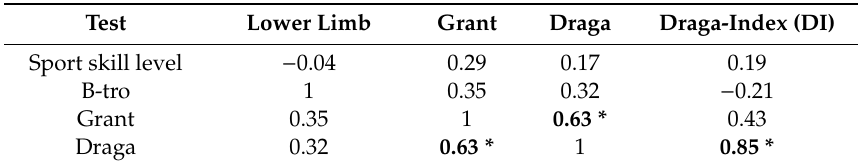
Table 4. Pearson’s linear correlations of motor variables and lower limb length with sport skill level on the Watts RP scale in the group of 7b–9a RP climbers. Test Lower Limb Grant Draga Draga-Index (DI) Sport skill level − 0.04 0.29 0.17 0.19 B-tro 1 0.35 0.32 − 0.21 Grant 0.35 1 0.63 * 0.43 Draga 0.32 0.63 * 1 0.85